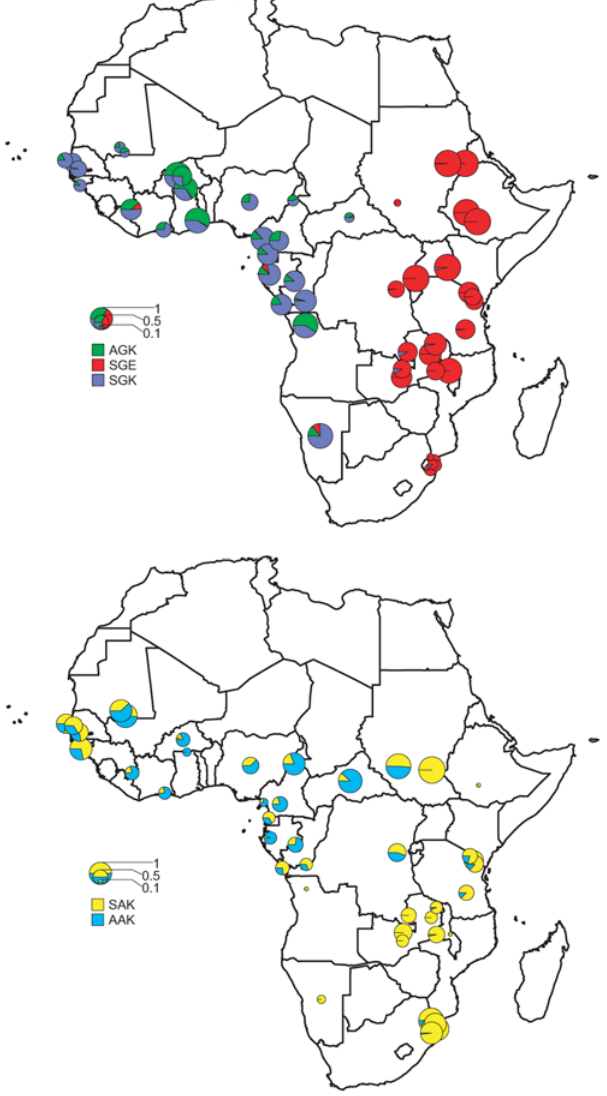
Figure 2. The distribution of the major dhps alleles across sub- Saharan Africa. Resistant alleles; the upper map shows the relative proportions of the three major resistance alleles, SGK, AGK, and SGE. Wild-type alleles; the lower map shows the ratio of SAK and AAK alleles among wild-type dhps alleles. In both cases the diameter of the pie is proportional to the combined frequencies of the alleles represented in the total population.